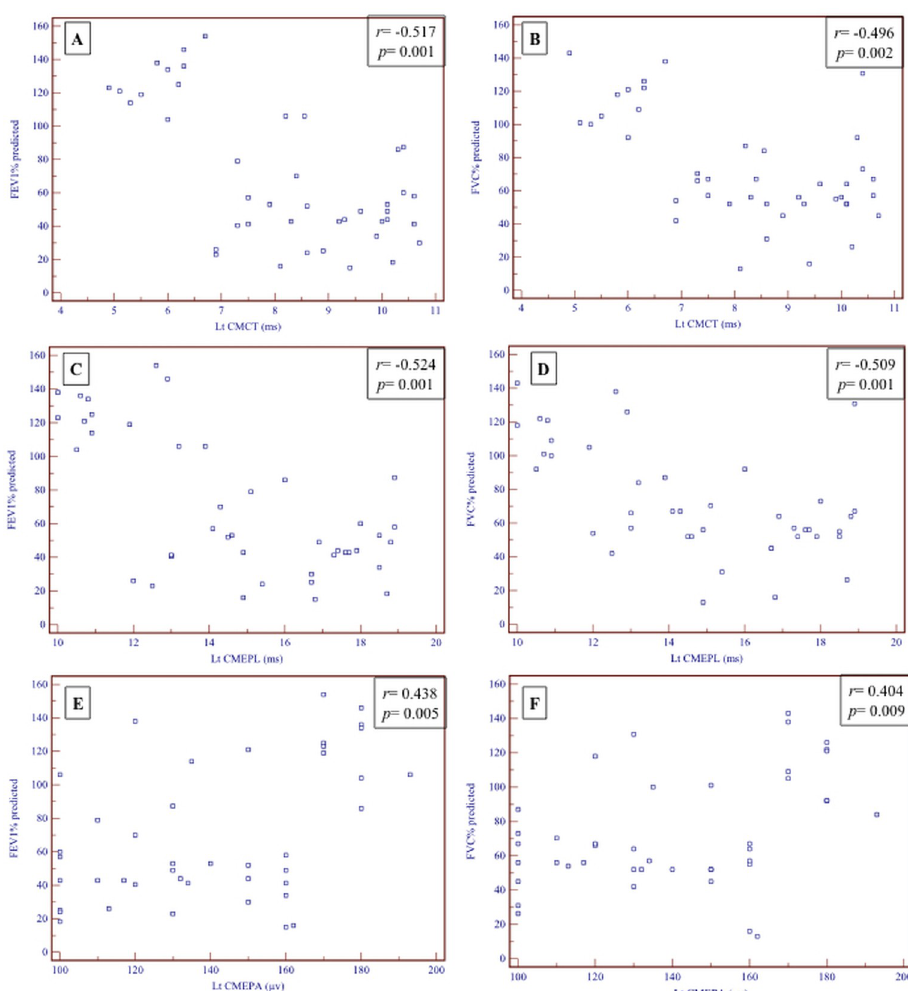
Fig 2. Correlations between spirometric parameters (FEV% predicted and FVC% predicted) and left CMEPs (A-F).